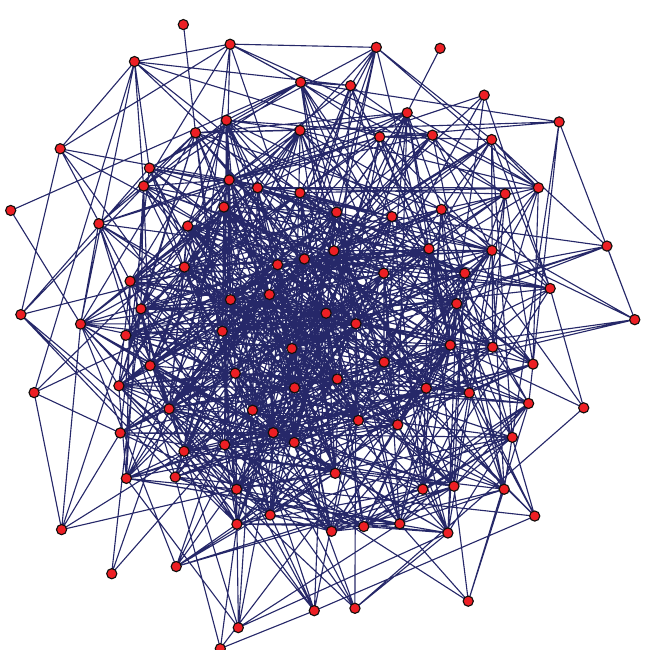
Figure 1: The random network (cid:7) Erdos-Renyi model (cid:8) examined consists of 100 nodes and was generated by the networks software PAJEK (cid:4) 20 (cid:5) . The clustering coe ffi cient for the unweighted network is 0.3615.